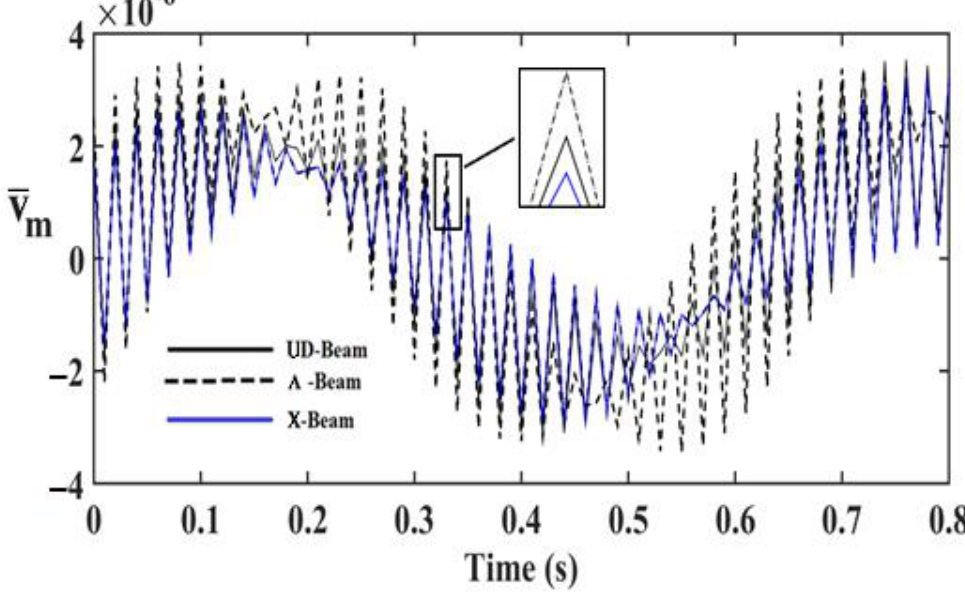
Figure 4. Time −responses of the CNTRC beam with different reinforcement pattern for V CNT = 0.28. Figure 4. Time − responses of the CNTRC beam with different reinforcement pattern for V CNT =